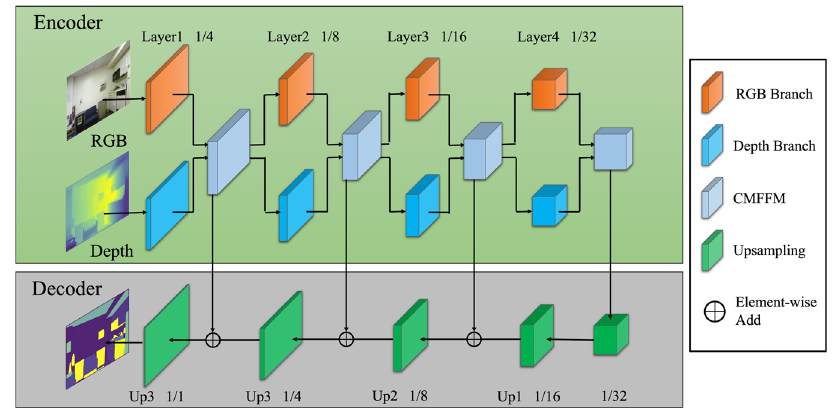
Figure 1. Framework Overview.